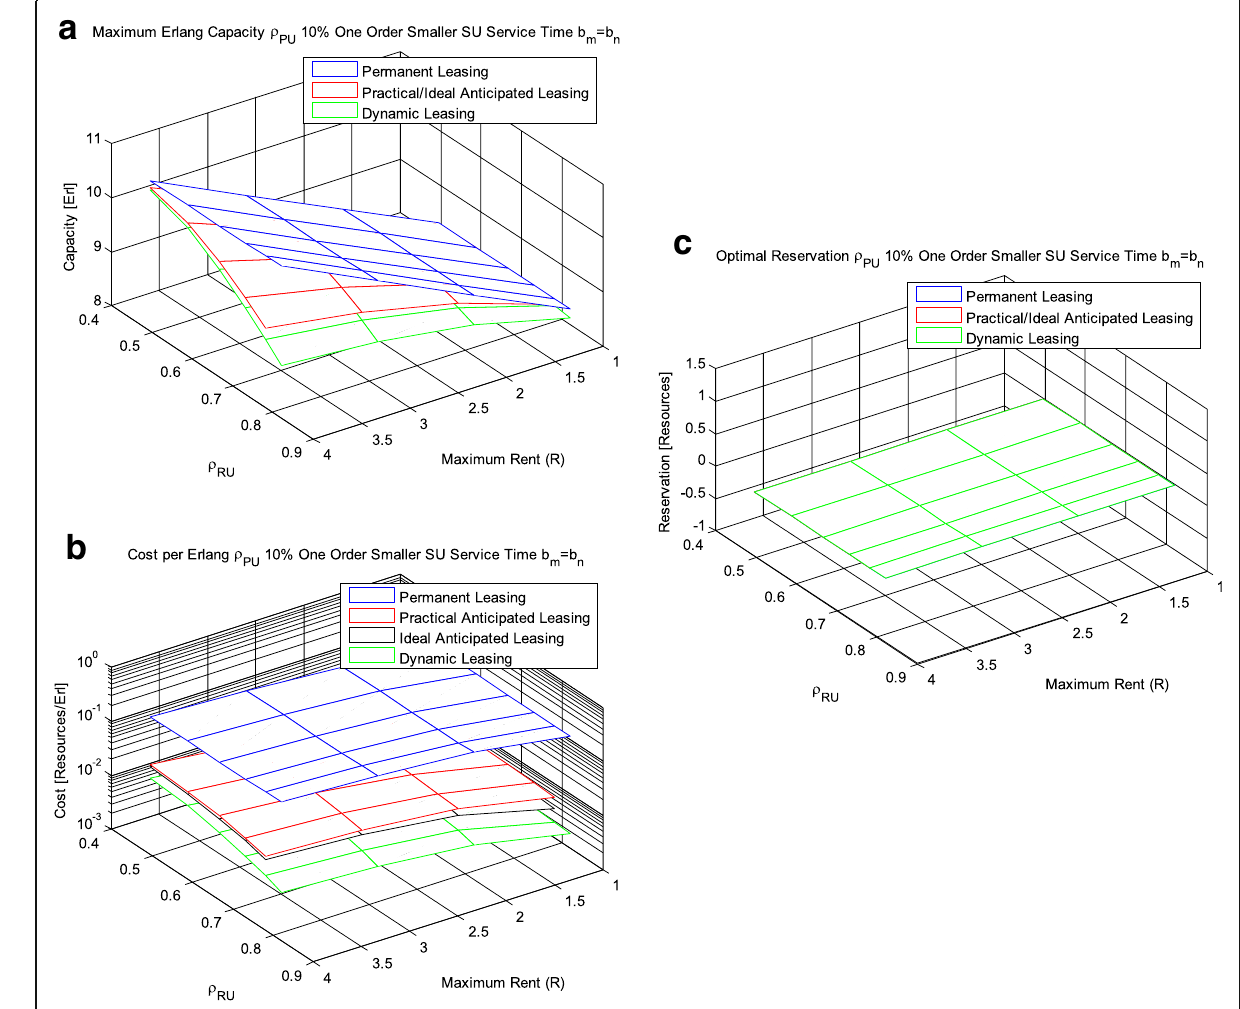
Fig. 8 Performance of spectrum leasing strategies under the system scenario in which ρ PU = 0.1, μ m / μ n = 0.1, and b m = b n . a Maximum Erlang capacity, b cost per rented resource per achieved Erlang capacity, and c optimal number of reserved channels as function of R and ρ